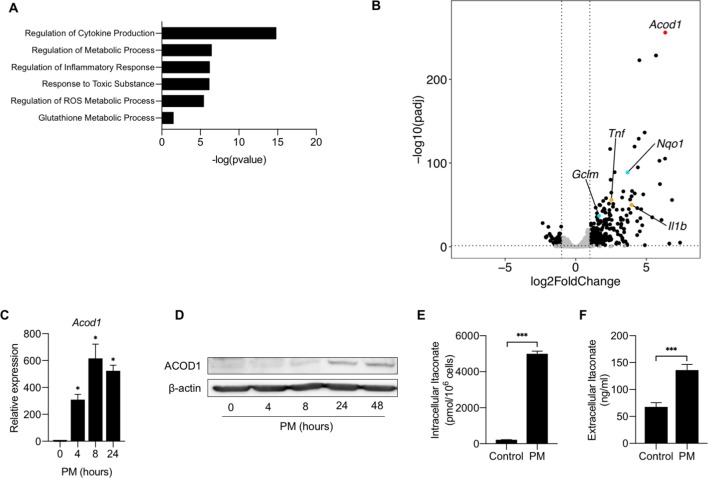
Aconitate Decarboxylase 1 (Acod1) is highly upregulated by particulate matter in macrophages.(A) We performed RNA-seq in BMDMs treated with either PM (20 μg/cm2) or vehicle control for 24 hours. Gene ontology analysis highlight the pathways involved with PM treatment. (B) Volcano plot of RNA-seq data representing differentially expressed genes in BMDMs treated with PM or PBS (vehicle control) for 24 hours. Acod1 (red point) is one of the most highly differentially expressed gene. In addition, we found induction of NRF2 target genes (i.e. Nqo1, Gclm; turquoise points) and inflammatory genes (i.e. Tnf, Il1b; orange points) following PM treatment. Black data points represent other significant genes, at FC > 2, and FDR adjusted p<0.05. (C) qPCR analysis of Acod1 in BMDMs treated with PM for 4, 8 or 24 hours. Data are represented as fold change. Significance was analyzed with one-way ANOVA corrected with Bonferroni’s post hoc test for multiple comparisons, *p<0.05, **p<0.01, ***p<0.001. (D) Western blot of ACOD1 protein at 0, 4, 8, 24 and 48 hours of PM treatment. (E) Intracellular itaconate concentration in BMDMs treated with PM for 24 hours, as measured by mass spectrometry. (F) Extracellular itaconate in media in BMDMs treated with PM for 24 hours, as measured using mass spectrometry. Significance was determined using two-tailed unpaired student’s t-test, *p<0.05, **p<0.01, ***p<0.001.
Figure 1—source data 1.Differential expression analysis results of PM treated BMDMs compared with Control BMDMs.